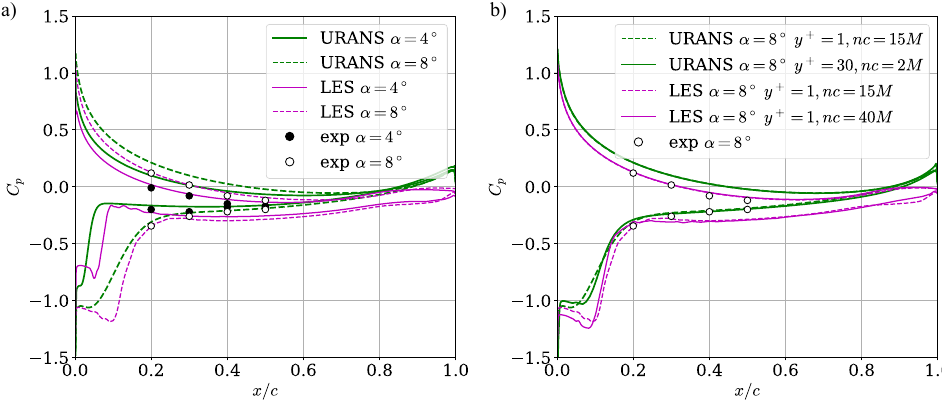
Figure 5. Comparison of surface pressure contours between RANS, time averaged LES and steady experiment. α = 4 ◦ and 8 ◦ at z ref / c = 0.24; ( a ) Mesh y + = 1, nc = 15 M , ( b ) mesh variation for α 0 = 8 ◦ .